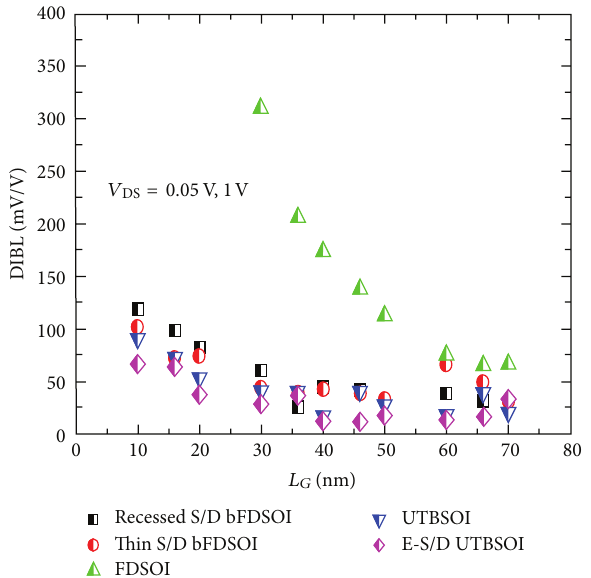
Figure 5: Simulated DIBL as a function of the gate length 𝐿 𝐺 for a = 0.05 V) and high drain bias ( 𝑉 low drain bias ( 𝑉 DS shown that the DIBL characteristics of the bFDSOI-FETs are better than those of the FDSOI-FET and similar to those of the UTBSOI- FET.